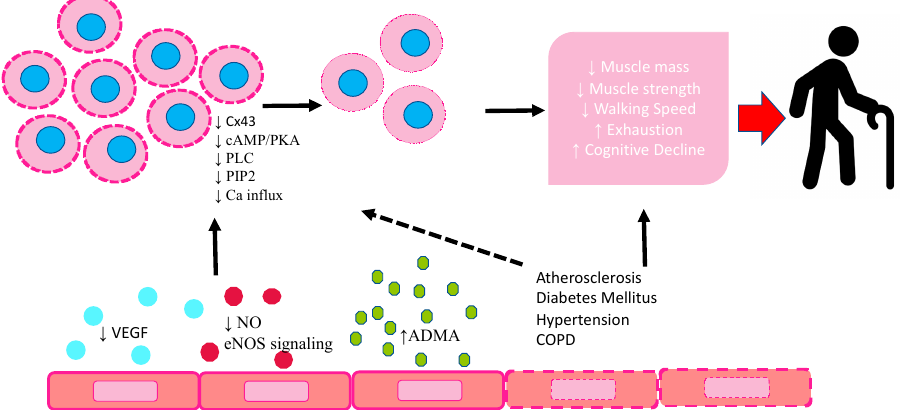
Figure 1. Schematic diagram highlighting the response of EPCs to endothelium dysfunction in frailty and their modification. VEGF: vascular endothelial growth factor; NO: nitric oxide; eNOS: endothelial nitric oxide synthetase; ADMA: asymmetric dimethylarginine; CX43: connexin 43; cAMP/PKA: cyclic adenosine monophosphate/ protein kinase A; PLC: phospholipase C; PIP2: phosphatidylinositol-4,5-bisphosphate.